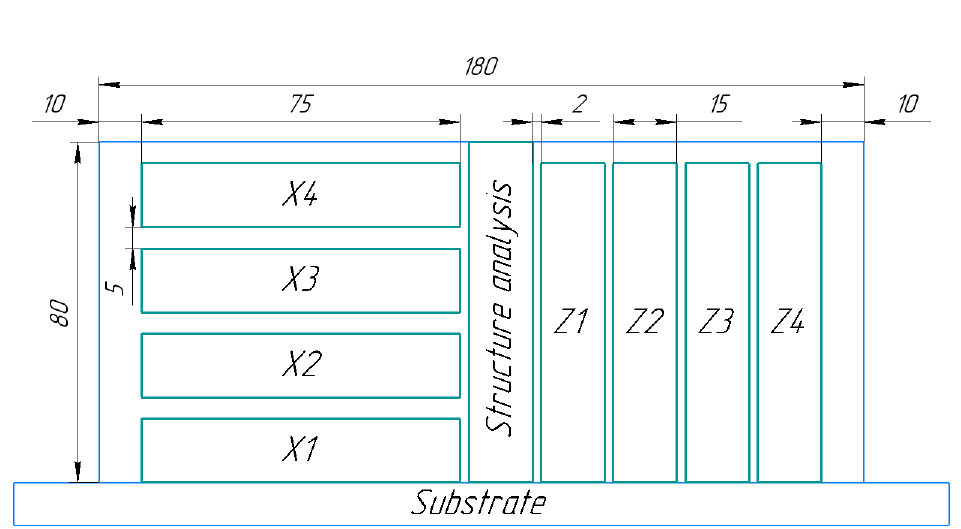
Figure 19. A schematic diagram of the method of cutting out specimens for mechanical testing and structural analysis: X1–X4 specimens for tensile tests in the horizontal direction, along the deposition direction; Z1–Z4 specimens for tensile test in the vertical direction. Table 3. Deposition modes and mechanical properties of specimens: ultimate tensile strengths (UTS), yield strengths (YS), and elongation (Elong.).